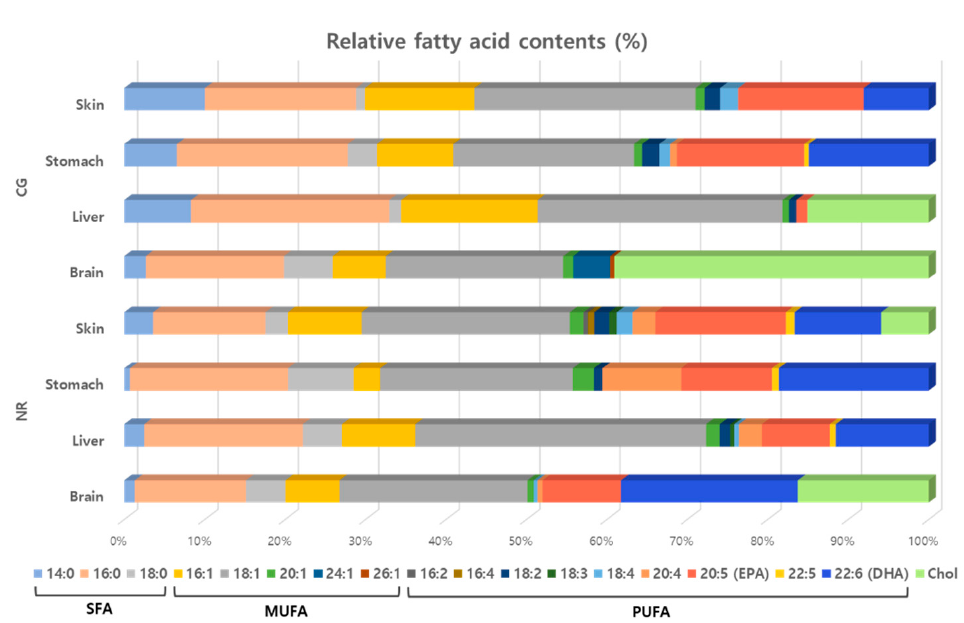
Figure 2. Bar representations of relative content (%) of fatty acids of different organs of N. rossii and C. gunnari .